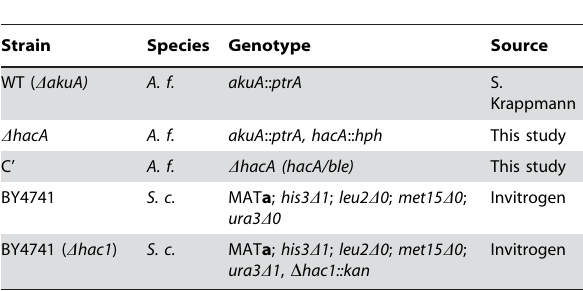
Table 2. Strains used in this study